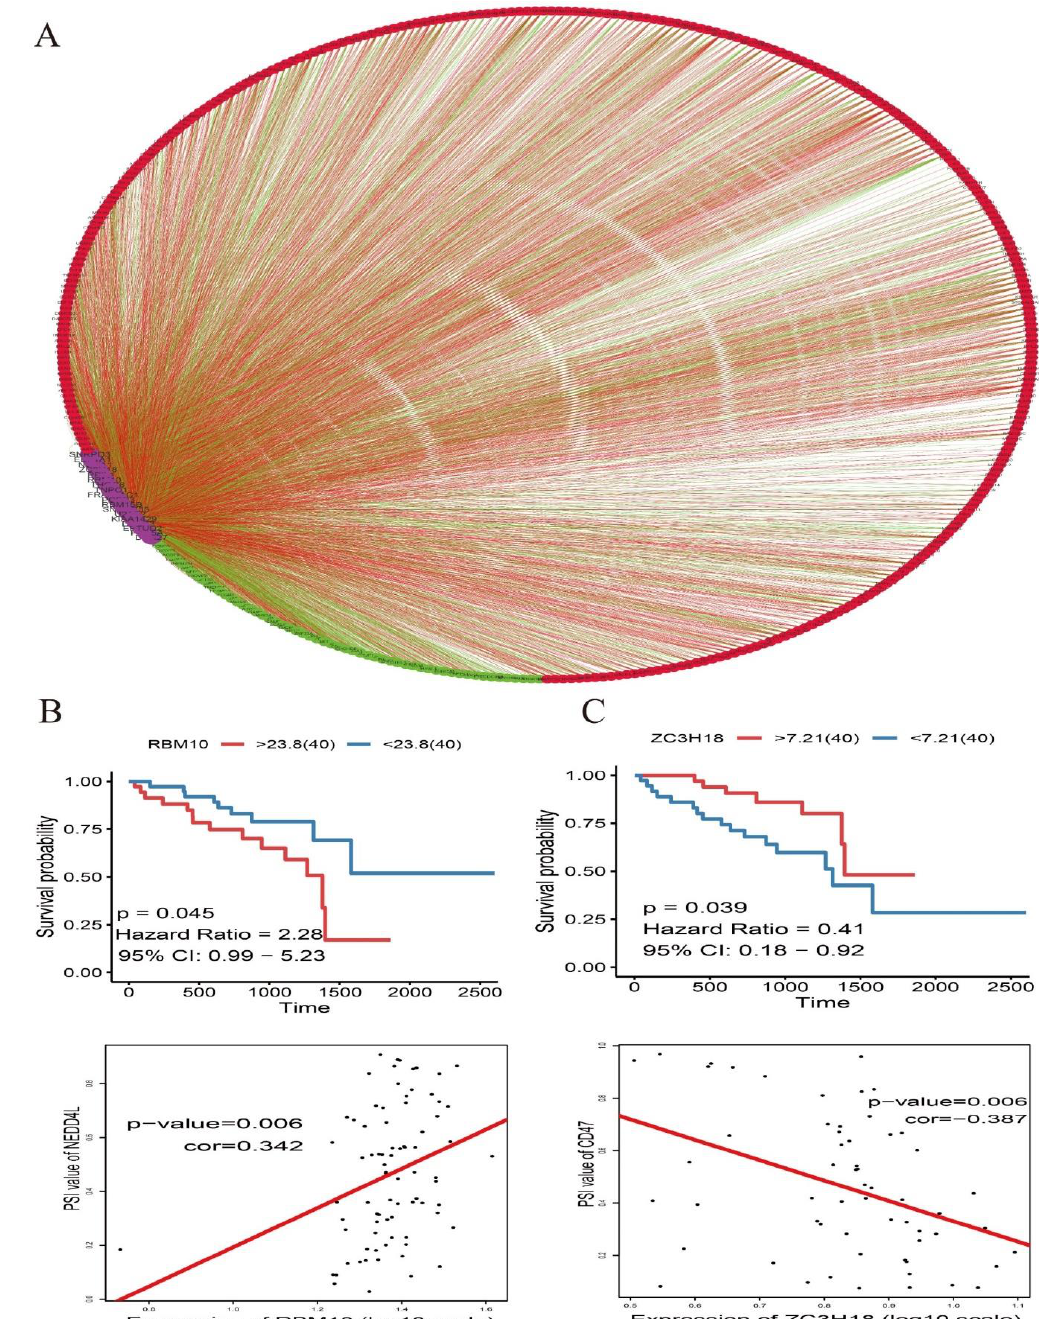
Figure 9. Survival-associated splicing factors and splicing correlation network in UM. ( A ) Splicing correlation network in UM patients constructed by Cytoscape. Eighteen survival-associated splicing factors (purple dots) were positively (red lines) or negatively (green lines) associated with AS events, which predicted good (green dots) or poor (red dots) outcomes in UM patients. ( B ) High RBM10 expression was significantly associated with poor overall survival in UM. Positive correlations between RBM10 expression and the Percent Spliced In (PSI) value of NEDD4L. ( C ) Low ZC3H18 expression was significantly associated with poor overall survival in UM. Negative correlations between ZC3H18 expression and the PSI value of CD47.